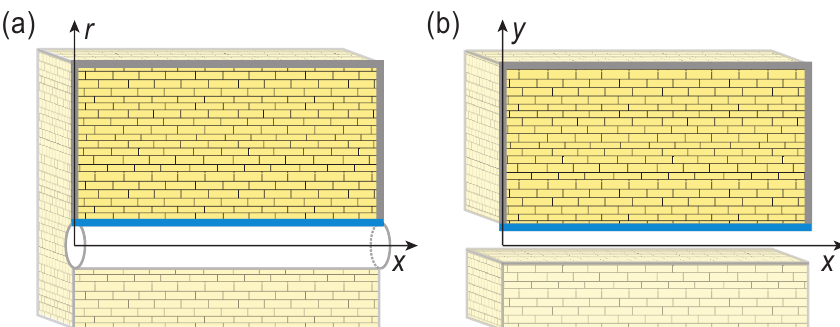
Figure 1. Model setup for heat transport simulations involving a (a) conduit or (b) fracture and the surrounding rock. The advection– dispersion equation is solved along the 1-D (a) conduit or (b) fracture. Because of symmetry, conduction in the 3-D rock surrounding the conduit or fracture may be modeled with a simple 2-D rectangle (outlined in thick gray and blue lines). Thus, conduction is modeled in (a) 2-D cylindrical or (b) 2-D planar coordinates. The 1-D conduit or fracture and the 2-D rock are coupled to each other at each respective thick blue line (i.e., the conduit/fracture wall surface). Thick gray limestone boundaries perpendicular to the conduit or fracture are insulated rock boundaries. Thick gray limestone boundaries parallel to the conduit or fracture are sufficiently far from flow path lines to satisfy Eqs. (7) or (9), respectively, and are set to background temperature.